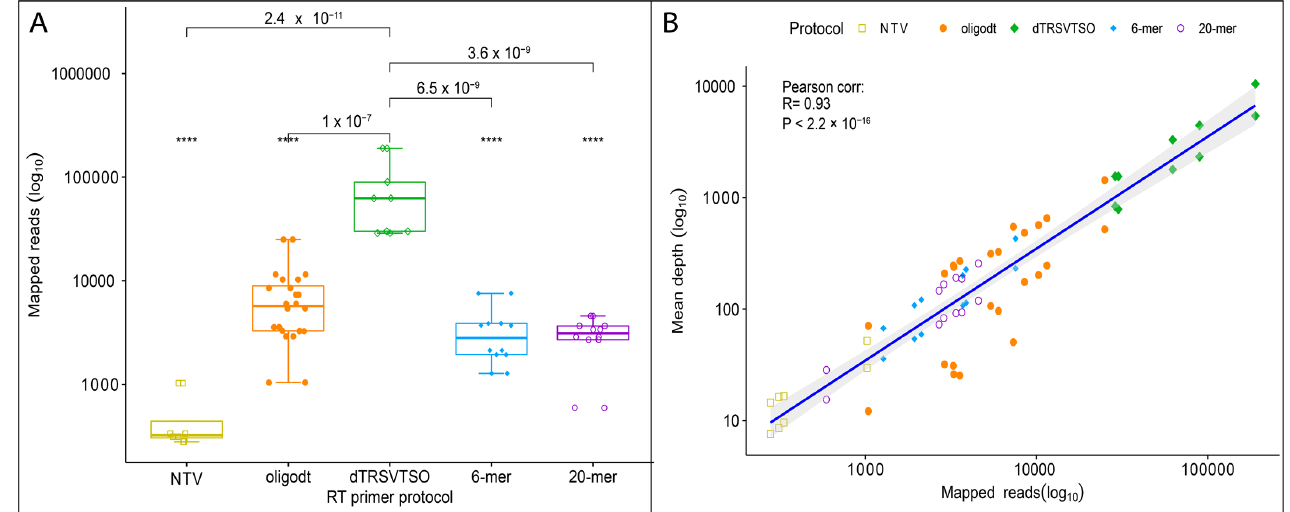
Figure 2. Comparison of libraries generated with TASPERT, OligodT, random 6-mer, and 20-mer RT-primers. ( A ) Number of reads mapped to the TRSV reference genome showing the highest pathogen abundance in the metagenome was achieved using the dTRSVTSO RT-primers. ( B ) Correlation between mapped reads and mean depth for TRSV showing dTRSVTSO primers allowed a larger number of mapped reads and deeper exploration during HTS of the sample. A group of non-target virus (NTV) acting as negative control was included. These NTVs did not contain TRSV but grapevine red blotch virus (GRBV). Statistical value meanings in the figure are: ****: p ≤ 0.0001.